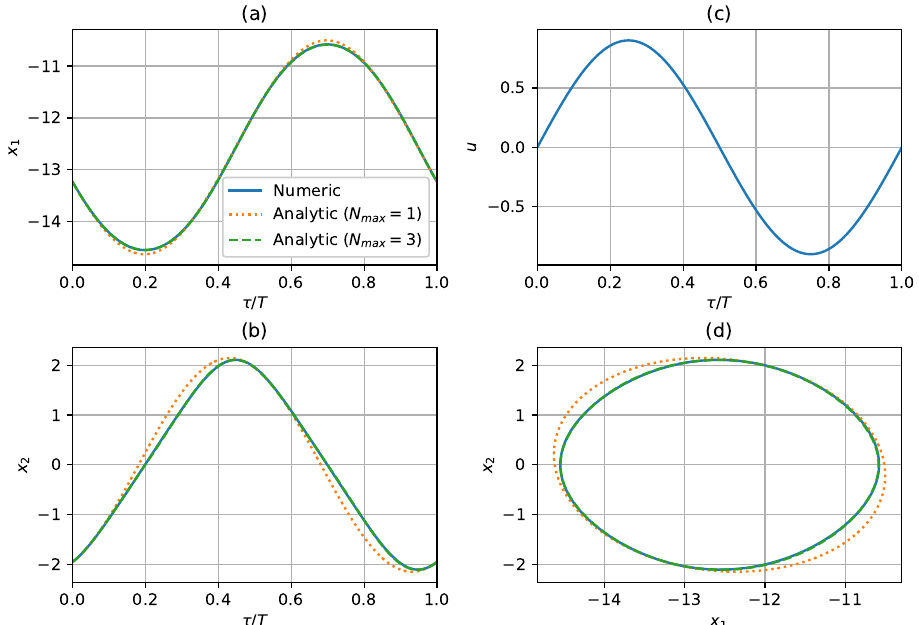
Figure 2. Comparison of the pendulum behavior predictions using the numerical and analytical solutions (69) ( N max = 1,3) for η = 0.1428, ω = 1, A = 0.9 and φ = 0 ( T = 2 π / ω ). ( a ) x 1 vs. τ / T , ( b ) x 2 vs. τ / T , ( c ) Input u vs. τ / T , and ( d ) phase plane ( x 1 , x 2 ) .